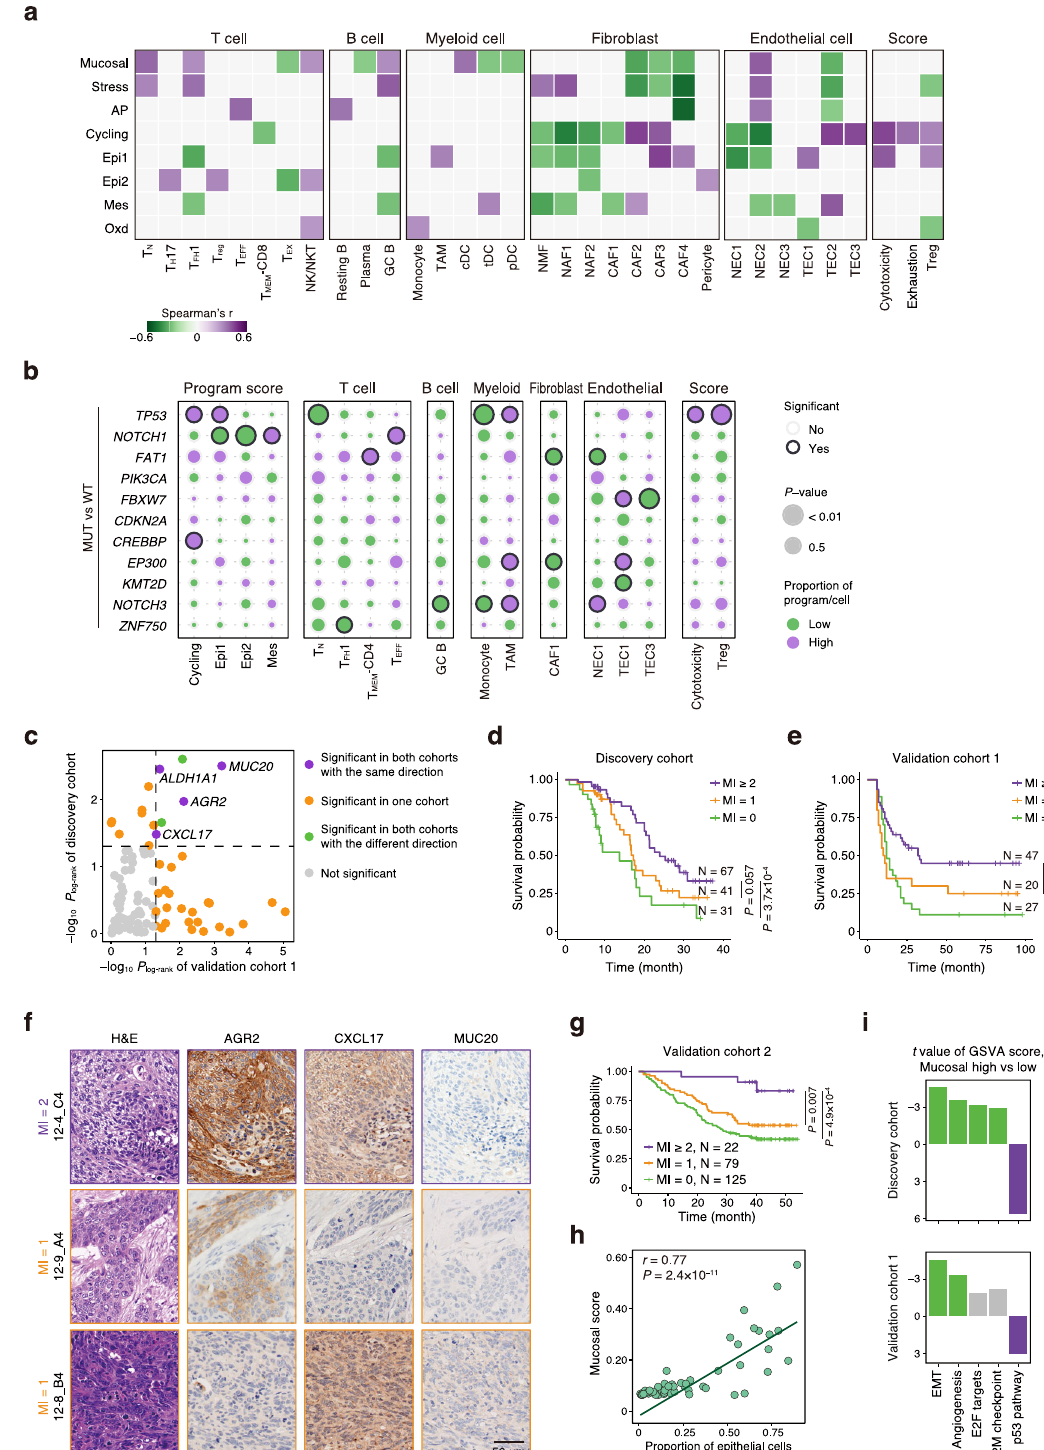
Fig. 6e, f). These results suggest that somatic mutations of some driver genes in esophageal epithelial cells may drive the alterations of epithelial expression programs and the TME compositions that facilitate tumor progression. Correlation of gene expression levels in the Mucosal program with ESCC survival in patients . Since epithelial